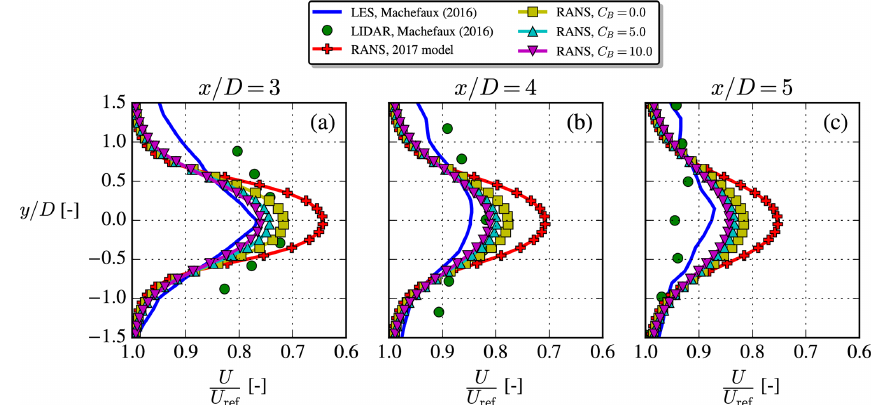
Figure 11. The unstable NTK41 case, where LES and experimental results were digitized from Machefaux et al. (2016). Profiles extracted at z = z ref .